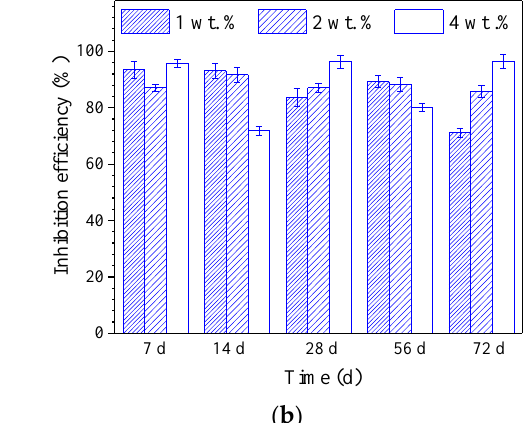
Figure 13. Calculated corrosion current density of the embedded reinforcement and inhibition. ( a ) Corrosion current density; ( b ) inhibition efficiency.